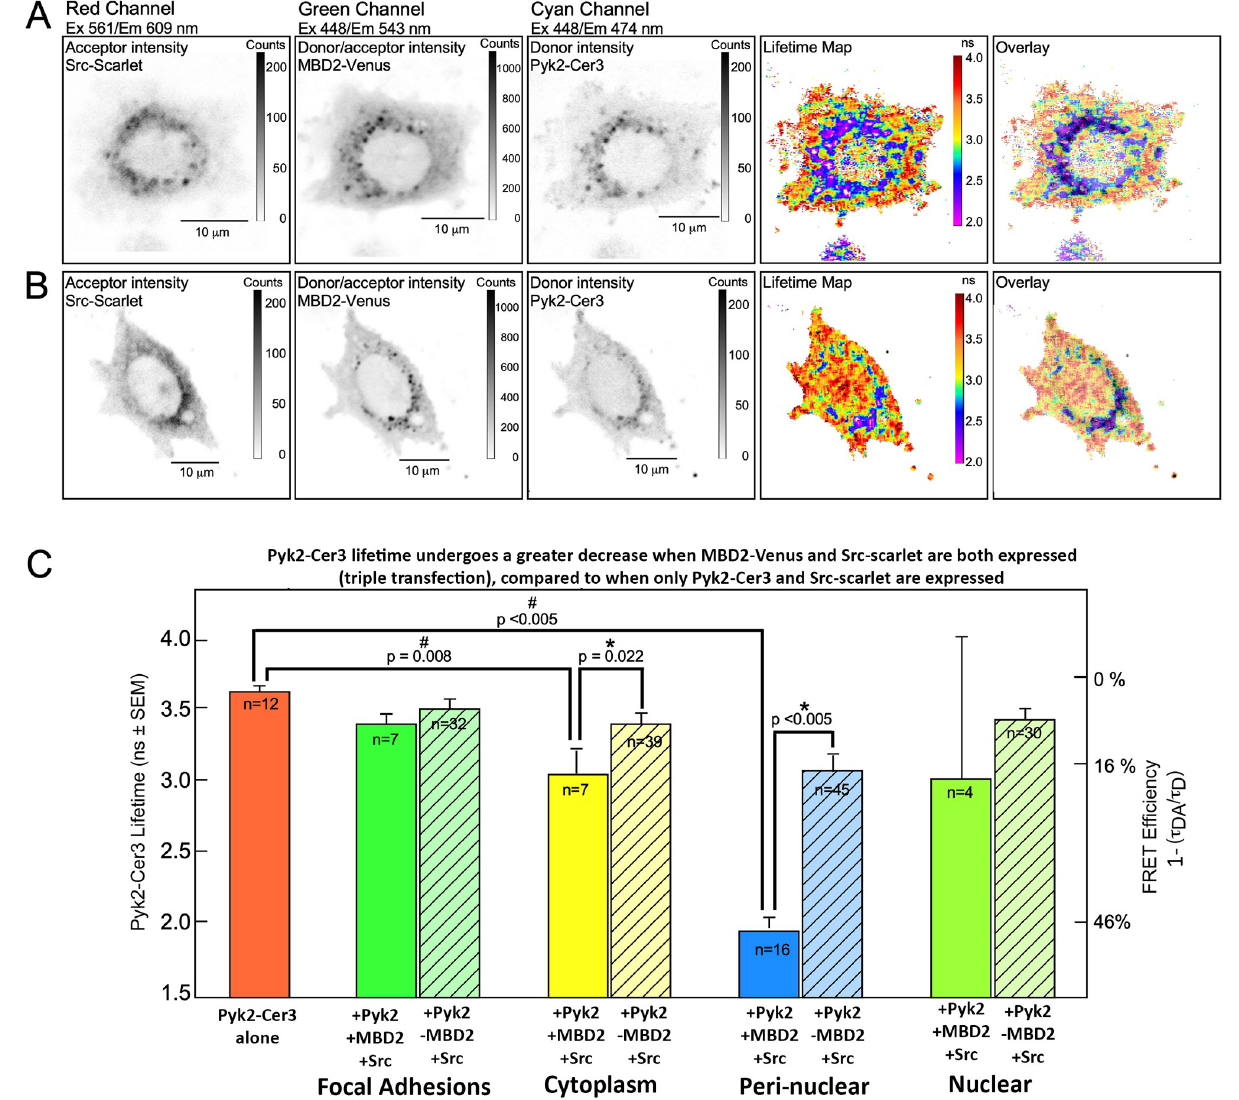
Fig 6. FRET between Pyk2-Cer3 and MBD2-Venus is altered when cells are triple transfected, particularly in the peri-nuclear region in MLO-Y4 cells. Panels A and B show two different representative cells that were triple-transfected with Src-Scarlet (acceptor), MBD2-Venus (donor or acceptor) and Pyk2-Cer3 (donor), as indicated above the rows. Lifetime maps and IMD overlays of the Lifetime map and donor intensity of Pyk2-Cer3 are shown on the rightmost two frames of each row. The graph below (Panel C) shows quantification of Pyk2-Cer3 lifetime in cells transfected with Pyk2-Cer3 alone (average of 3.65 ns, orange bar on the far left side) and in four ROI from cells co-expressing Pyk2, MBD2 and Src, or expressing only Pyk2 and Src (without MBD2) as indicated along the x-axis. Note that the data from the striped bars is obtained from the experiments shown in Fig 2. The Pyk2-Cer3 lifetime in the peri-nuclear region and cytoplasm ROI in cells expressing MBD2 (solid bars) was significantly shorter compared to cells not expressing MBD2 (striped bar). The Pyk2-Cer3 lifetimes were also significantly shorter in the peri-nuclear and cytoplasm ROI in cells expressing MBD2 compared Pyk2-Cer3 alone ( � p values are as indicated between the groups